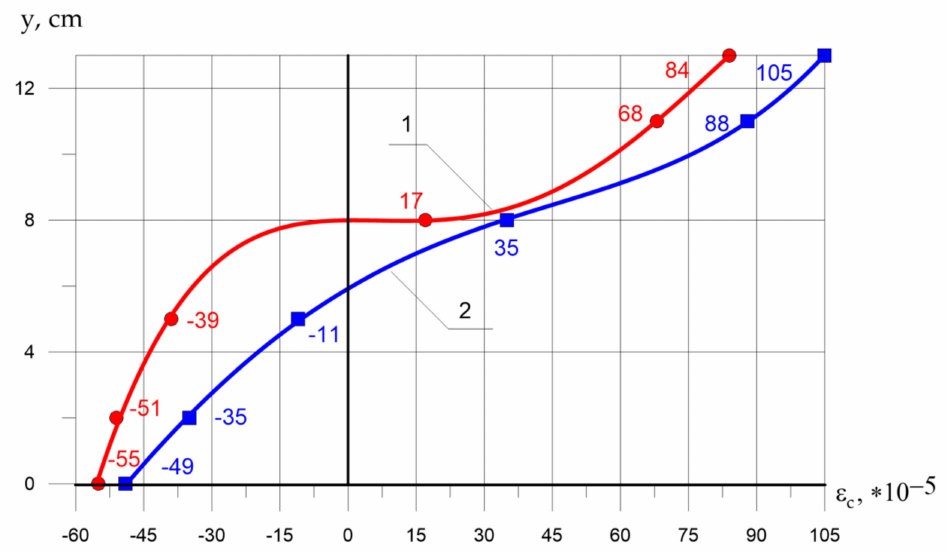
Figure 7. Dependence of longitudinal strains in the cross section in columns KK-0.6 (1) and KKF-0.6 (2) at a load of 60 kN.